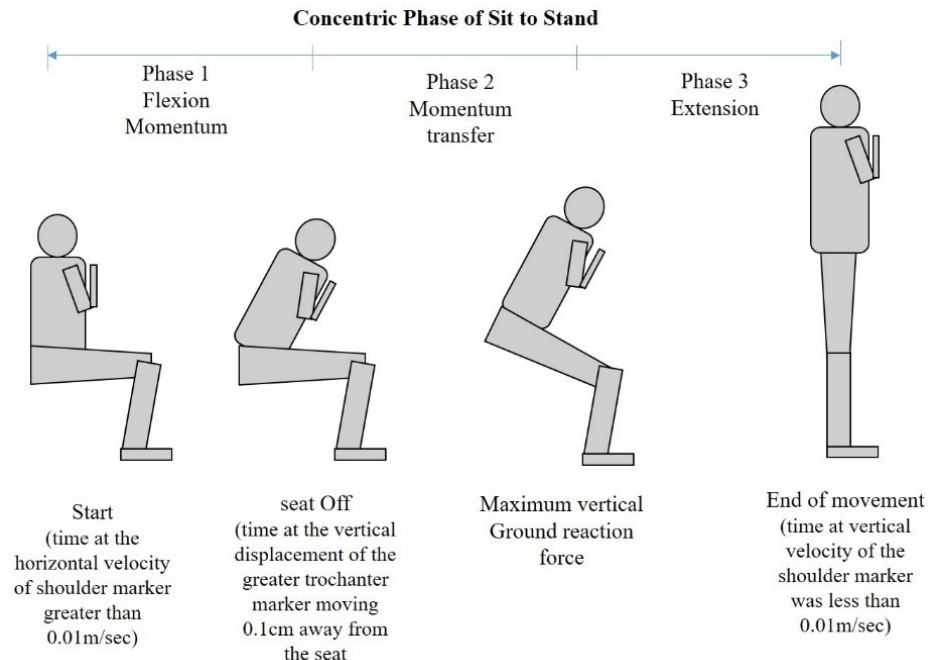
Figure 1. Concentric phase of sit to stand. Phase 1 is the flexion momentum, which began with the initiation point of the trunk and ended with seat-off. Phase 2 is the momentum transfer, which began with seat-off and ended when the maximum vertical ground reaction force occurred. Phase 3 is the extension phase, which began with the maximum vertical GRF and ended with the movement.